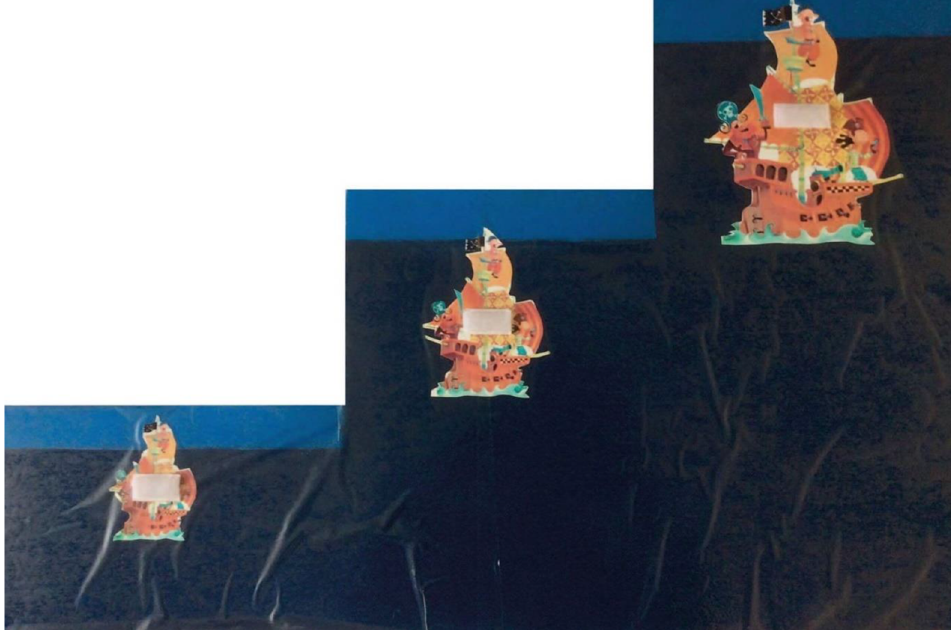
Figure A1. Pirate stair where children were invited to place picture from “not able “level (step 1, small ship), to “able” level (step 3, big ship).